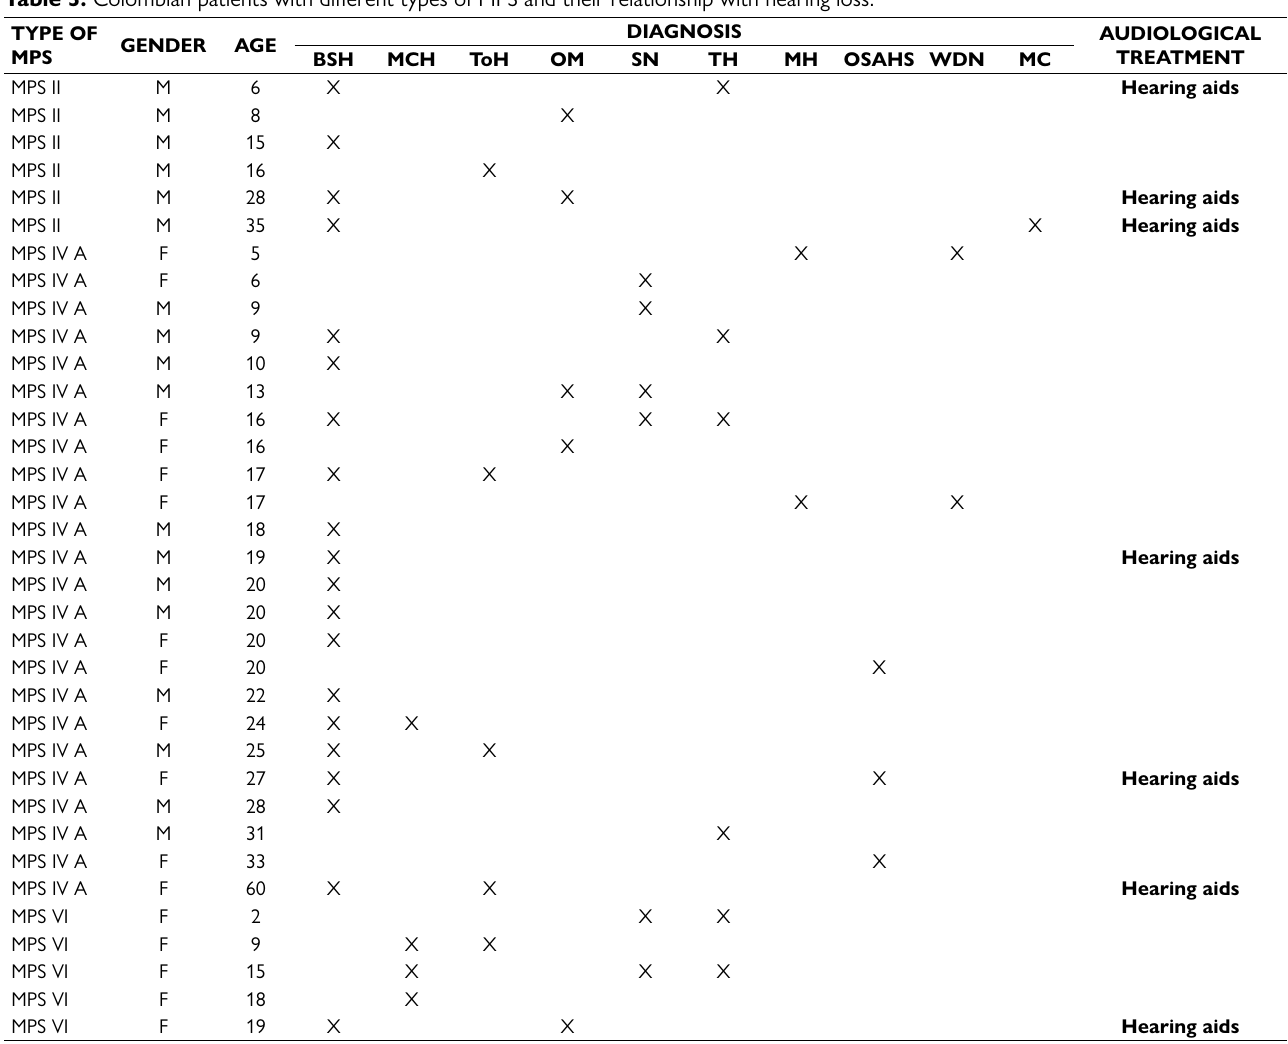
Table 3. Colombian patients with different types of MPS and their relationship with hearing